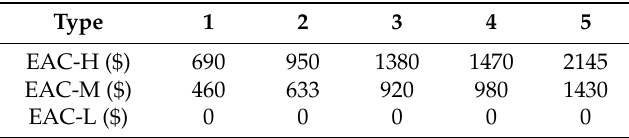
Table 3. Three sets of EACs.